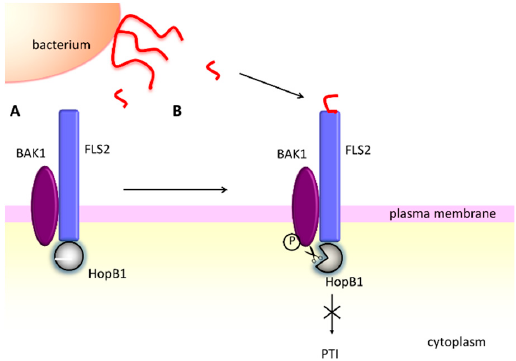
Figure 4. The HopB1 effector protease from P. syringae suppresses the PTI plant response [135]. ( A ) HopB1 constitutively interacts with the unstimulated FLS2 receptor. ( B ) When the activated receptor complex is formed, HopB1 degrades phosphorylated BAK1 and blocks the PTI response. AvrRpt2 is a cysteine protease of P. syringae pv. tomato that undergoes activation and